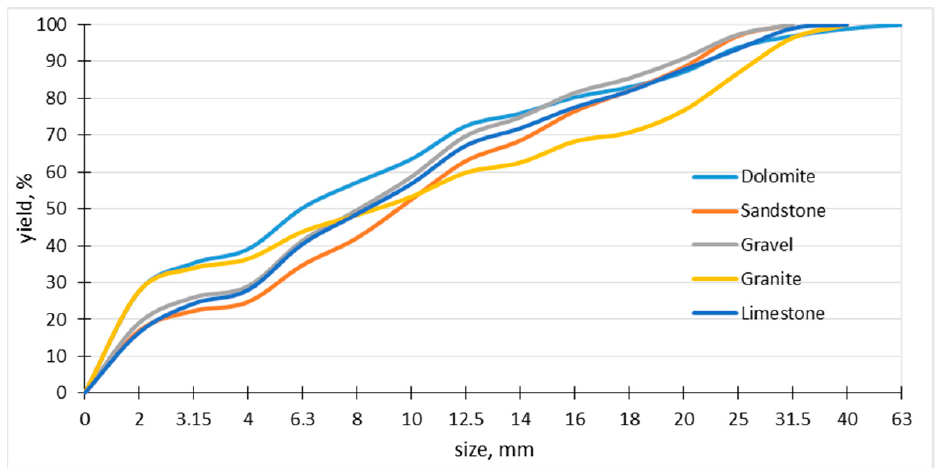
Table 4. Characteristics of raw materials and operation of the crusher.